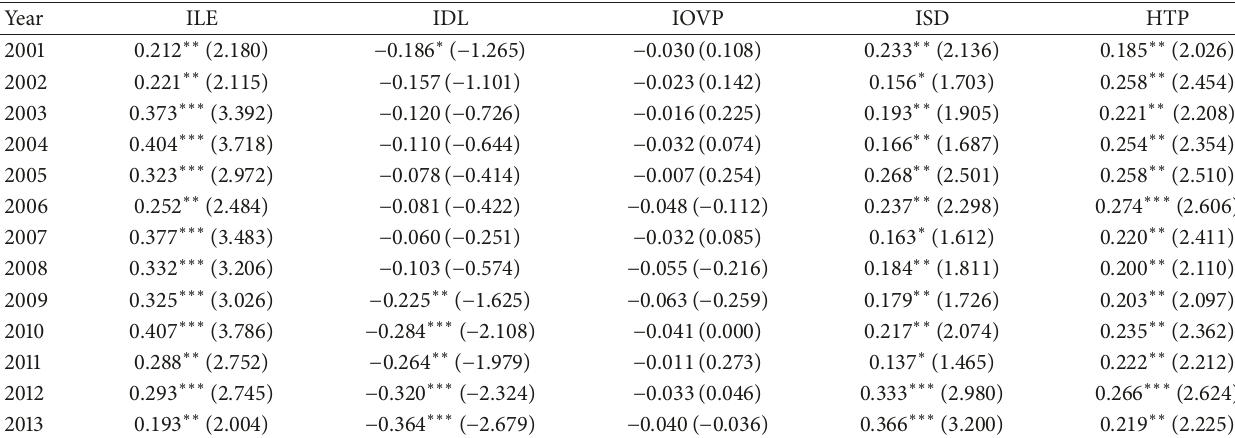
Table 1: Moran’s I of industrial land use efficiency and industrial development level.